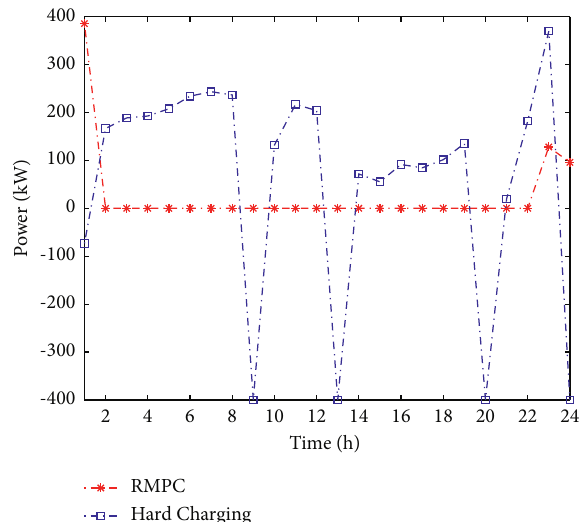
Figure 10: Comparison of the discharging of ESS between RMPC and HC